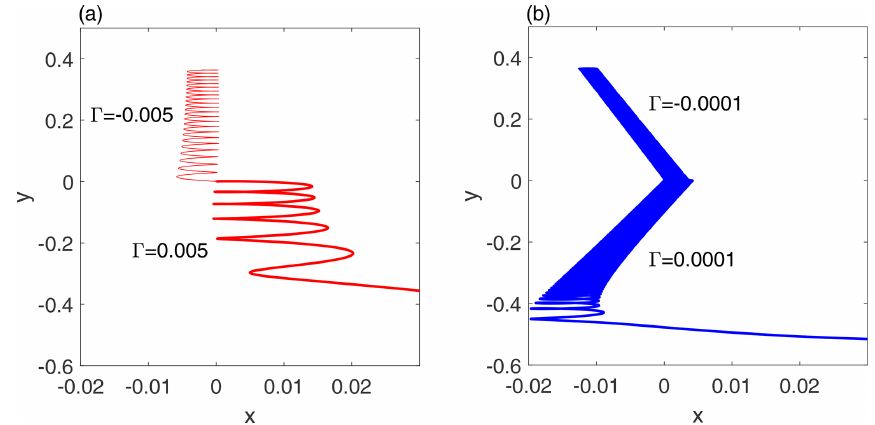
Figure 5. The different water column trajectories for b = 2 with initial conditions x = y = D = 0 and V = 0 . 002. (a) Large | (cid:48) | (red curves), (b) small | (cid:48) | (blue curves). The values of (cid:48) are noted near each of the curves: thin curves denote negative (westward-directed) stresses, and thick curves denote positive (eastward-directed) stresses. The integration time is 2 t cr in all cases, but the curves terminate just prior to reaching the Equator. Note that for (cid:48) = 0 . 00001 the integration time, 1 , is 5000; i.e., the columns in the right panel complete several b(cid:48) thousand oscillations in the course of the